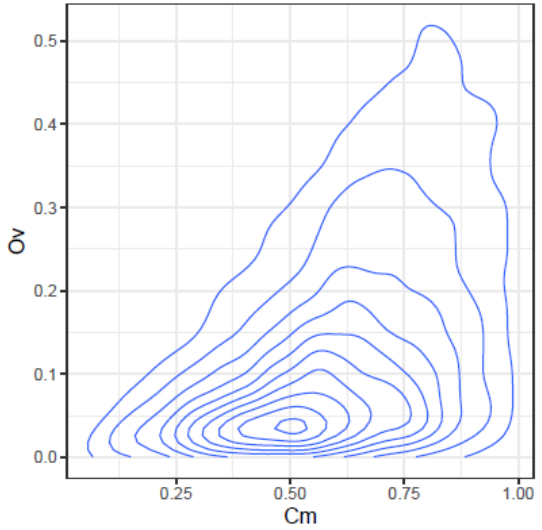
Figure 3. Joint density of C m and O v